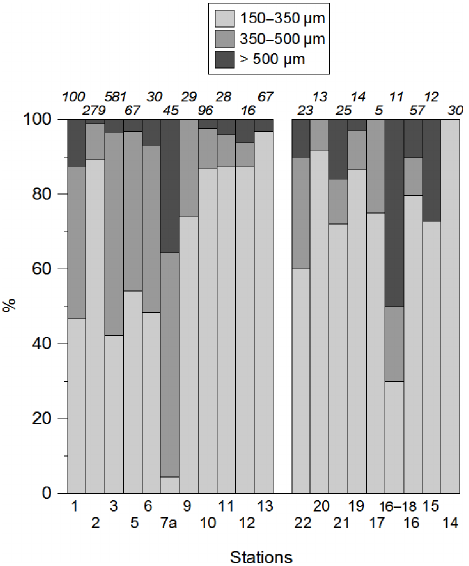
Figure 5. Percentage of each planktic foraminifera size fraction in each station from leg 1 (stations 1 to 13) and leg 2 (stations 22 to 14). Sample size is indicated in italics at the top of each station